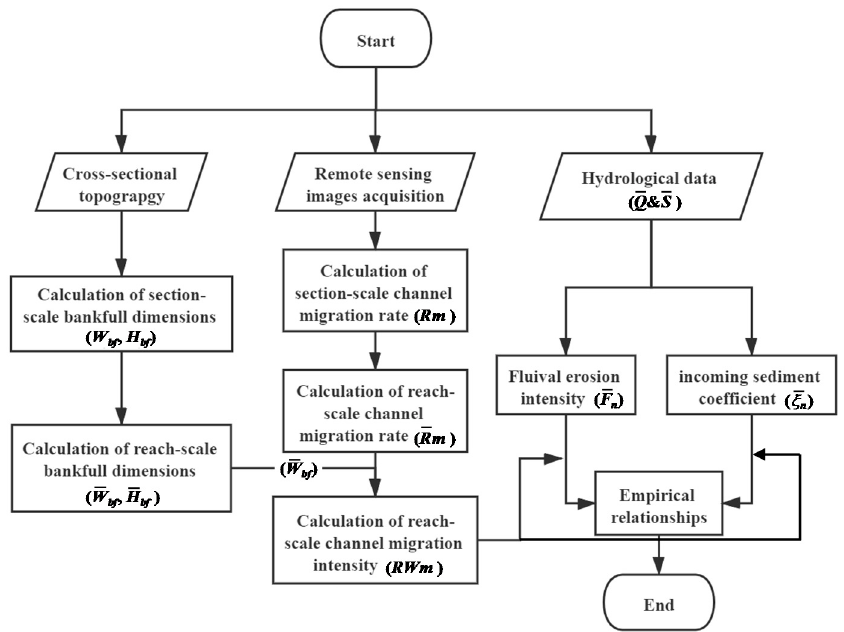
Figure 6. Flow chart of calculating the migration rate and intensity of channel centerline.